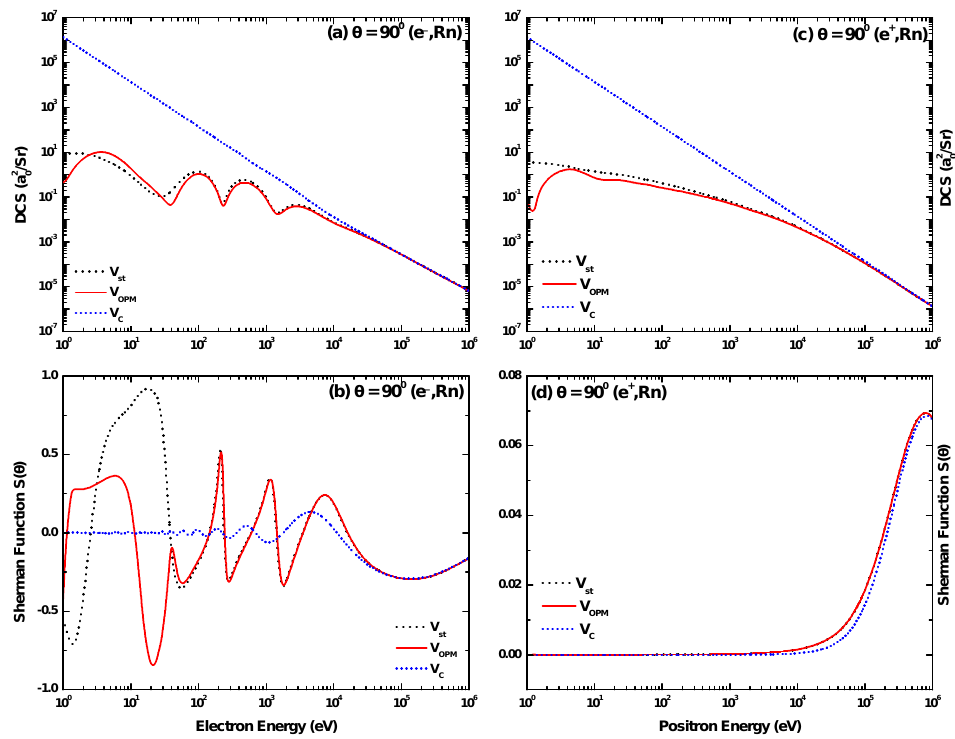
Figure 5. Energy dependence of ( a , c ) the DCS and ( b , d ) the Sherman function S ( θ ) for electron ( a , b ) and positron ( c , d ) impact scattering from 222 Rn at a scattering angle of 90 ◦ . Shown are the results from V st ( · · · · · · , black), V opt (——-, red) and V c ( · · · · · · ,